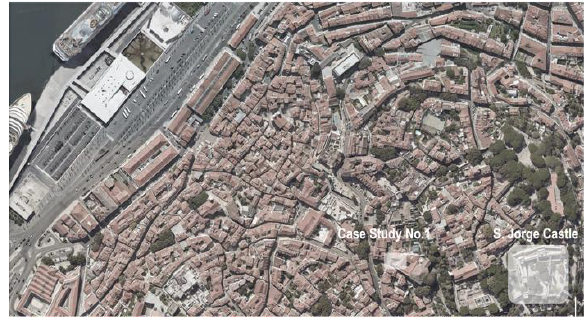
Figure 1. Location of case study No.1, Rua dos Cegos no.20,